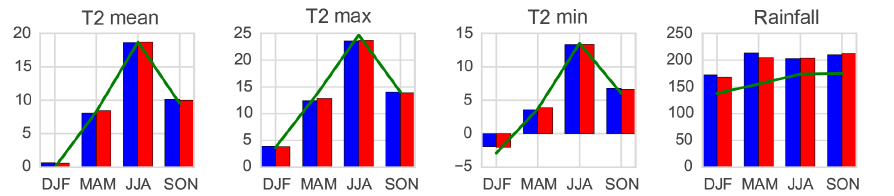
Figure 2. Averaged seasonal modelled temperature ( ◦ C) and precipitation (mm; CBMZ – blue, RADM2 – red). Green curve stands for the seasonal values given by E-OBS.